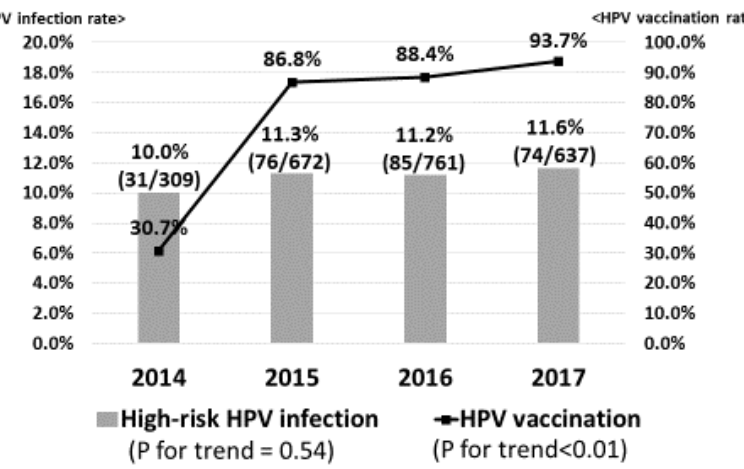
Figure 1. High-risk human papillomavirus (HPV) infection. The HPV vaccination rate was significantly increased from 28.6% in 2014 to 80.0% in 2017. However, the prevalence of high-risk HPV infection was slightly increased from 10.4% in 2014 to 12.4% in 2017.